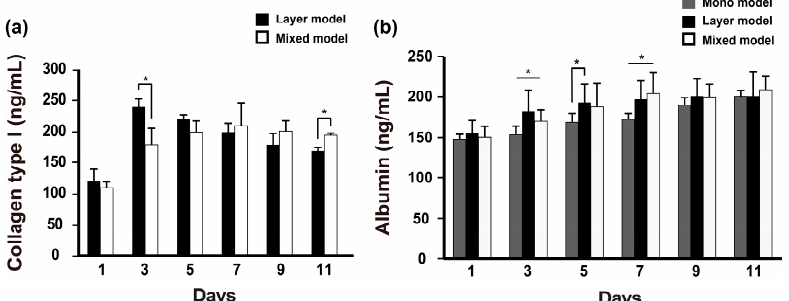
Figure 3. Albumin and collagen type I secretion from the experimentally designed models. ( n = 3, * p < 0.05).